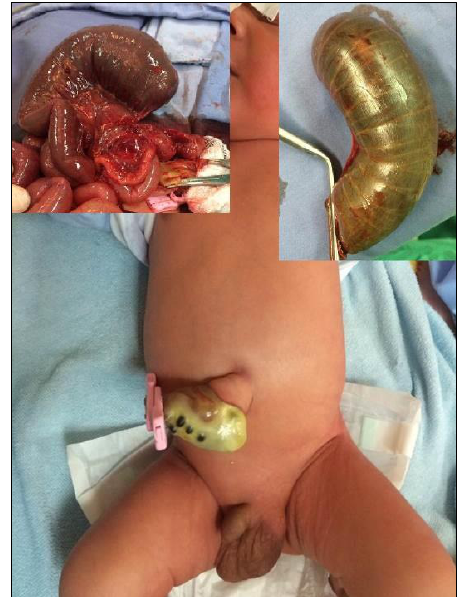
Figure 6: The patient presented with HUC on exploration a sequestered meconium filled loop was found as HUC content (left inset). The other inset shows associated distal ileal atresia. [Courtesy of Professor Naeem Zafar Khan of KRL Hospital and National Institute of Handicapped Islamabad, Pakistan]